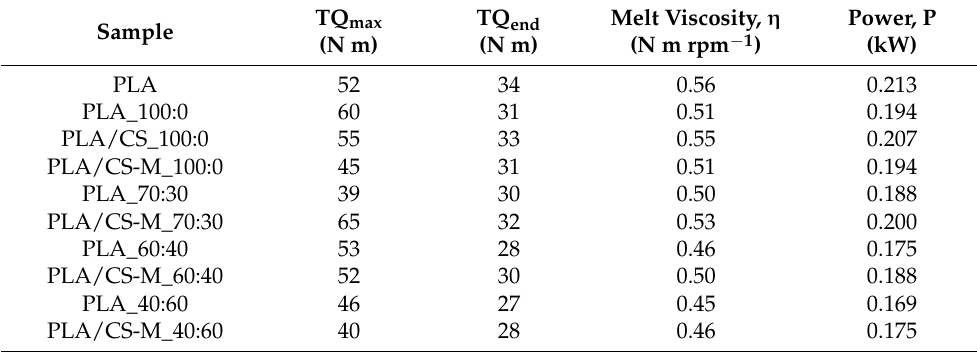
Table 2. Melt processing characteristics of PLA-based materials containing MB and PEG bio-plas- ticizers, in different ratios, CS-M and vitamin E.